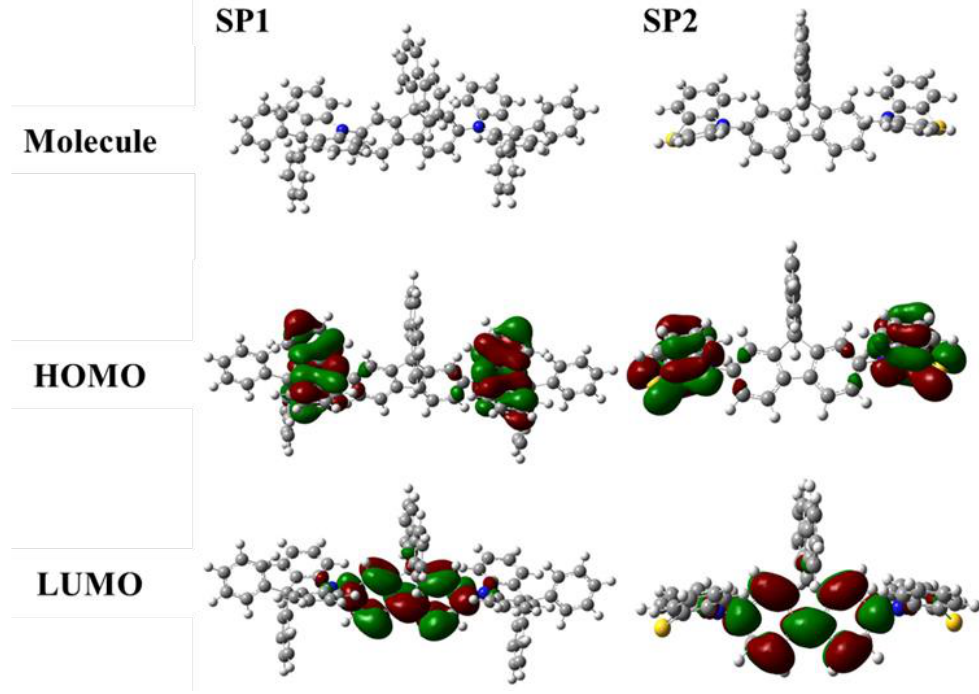
Figure 6. Molecular orbital simulation results of diphenylacridine (SP1) and phenothiazine (SP2).